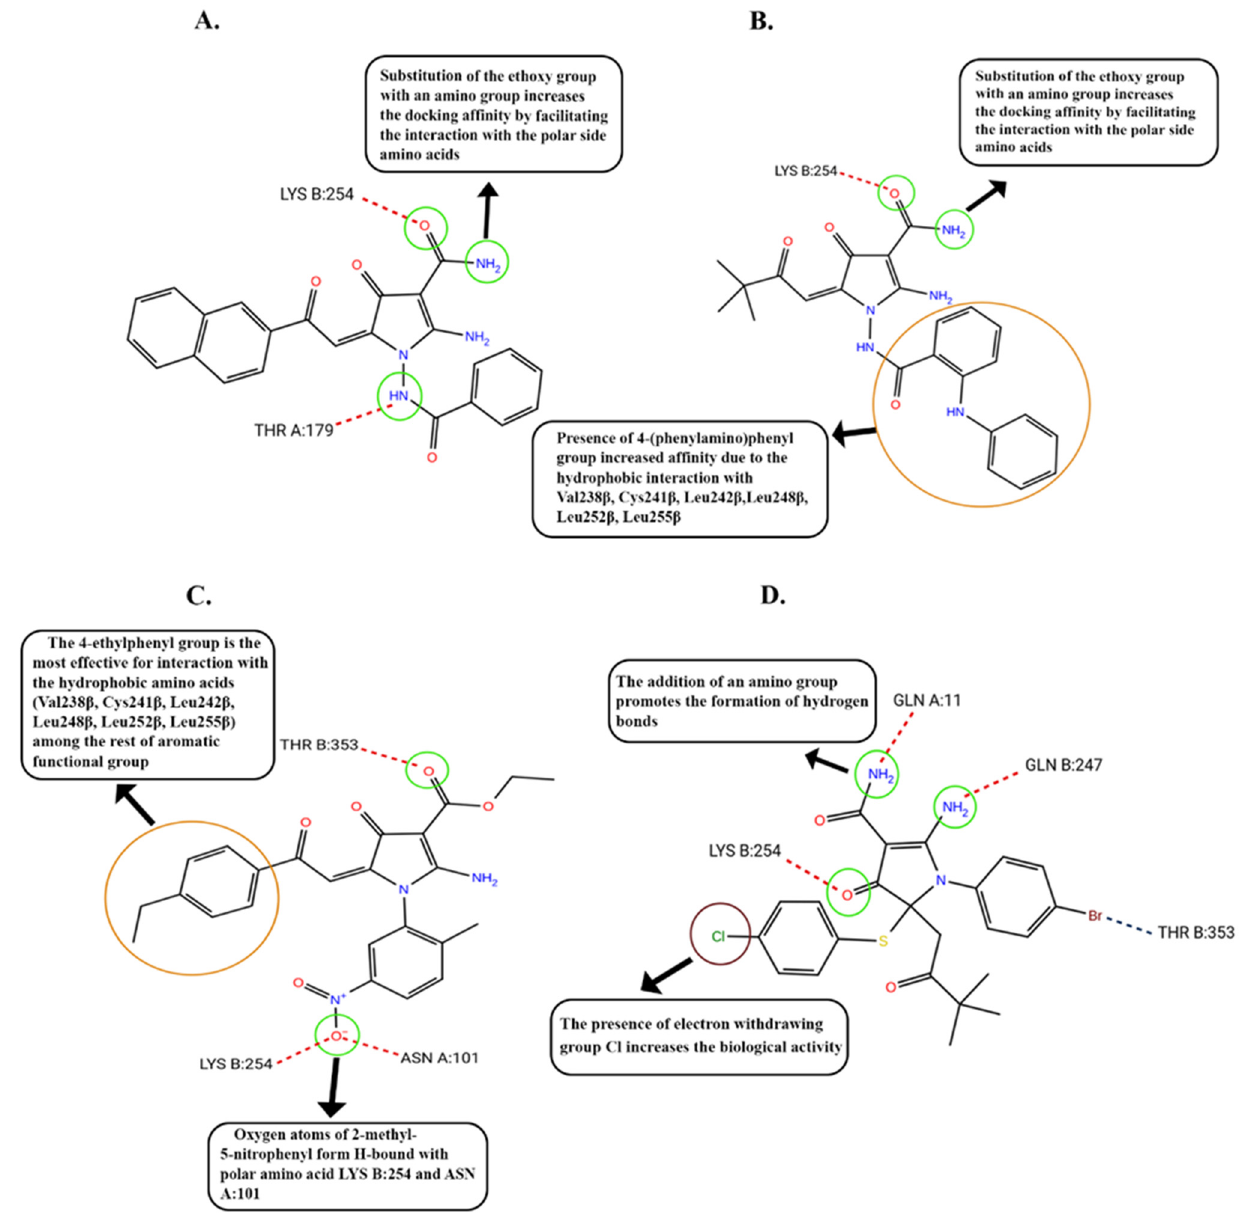
Figure 2. The structures of CA-61 ( A ), CA-84 ( B ), CA-166 ( C ) and CA-1489I ( D ). Amino acid residues and functional groups, responsible for highest biological activities are highlighted in the circles.